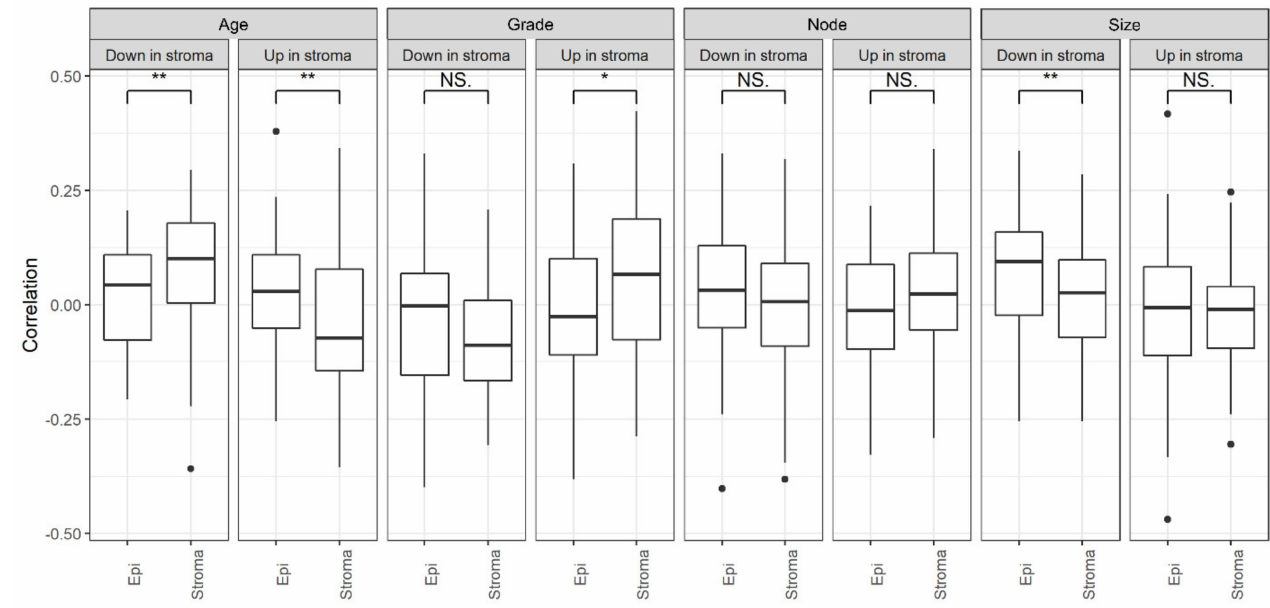
Figure 5. Compartment-specific relationship with clinical features for genes regulated in tumor stroma. Spearman’s correlation between gene expression and age at onset, tumor grade, lymph node status, and size for the classes of DEGs regulated only in tumor stroma, calculated for each dataset separately and then averaged. The correlation was computed when their expression was measured directly in the stroma or in the epithelium and was compared with the Wilcoxon test (* <0.05, ** <0.01, NS = Not